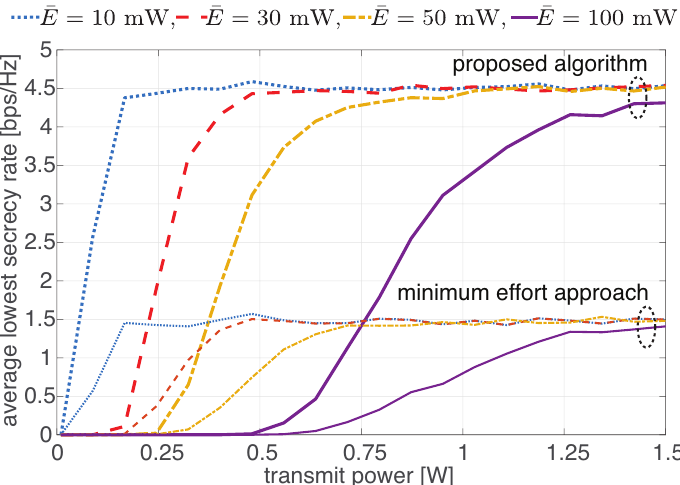
Figure 5. Average of the lowest total secrecy rate as a function of transmit power with varied minimum required harvesting